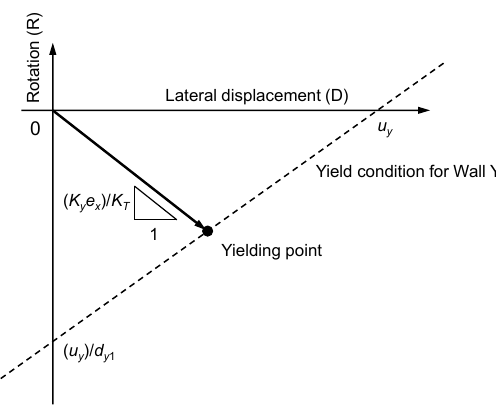
Figure 2. Lateral displacement-rotation (D-R) coordinate system.